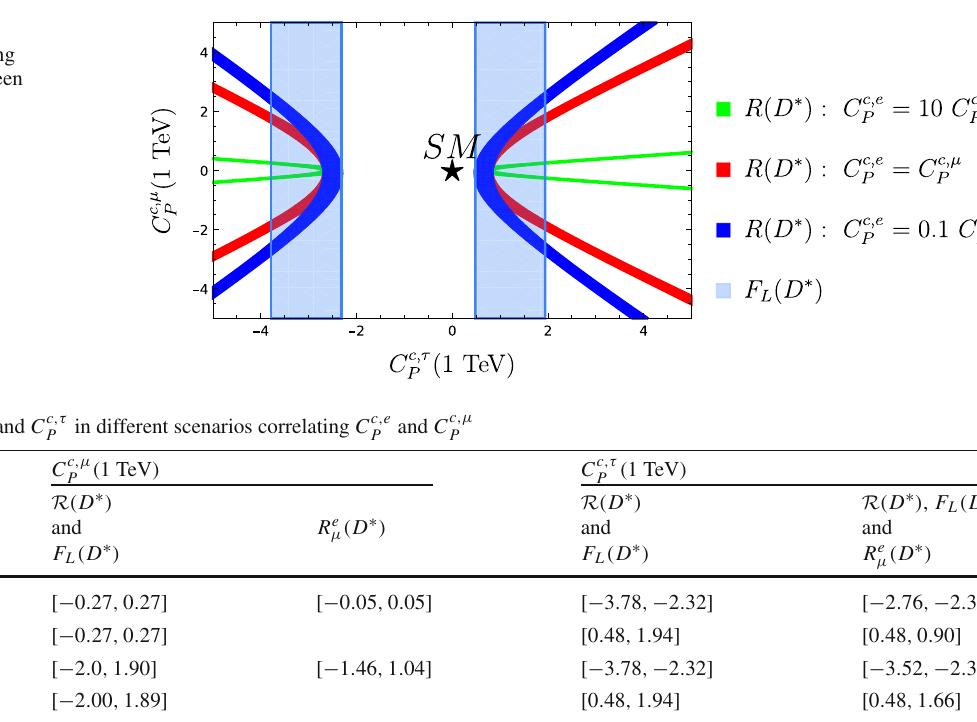
Fig. 9 Constraints in the C c ,τ